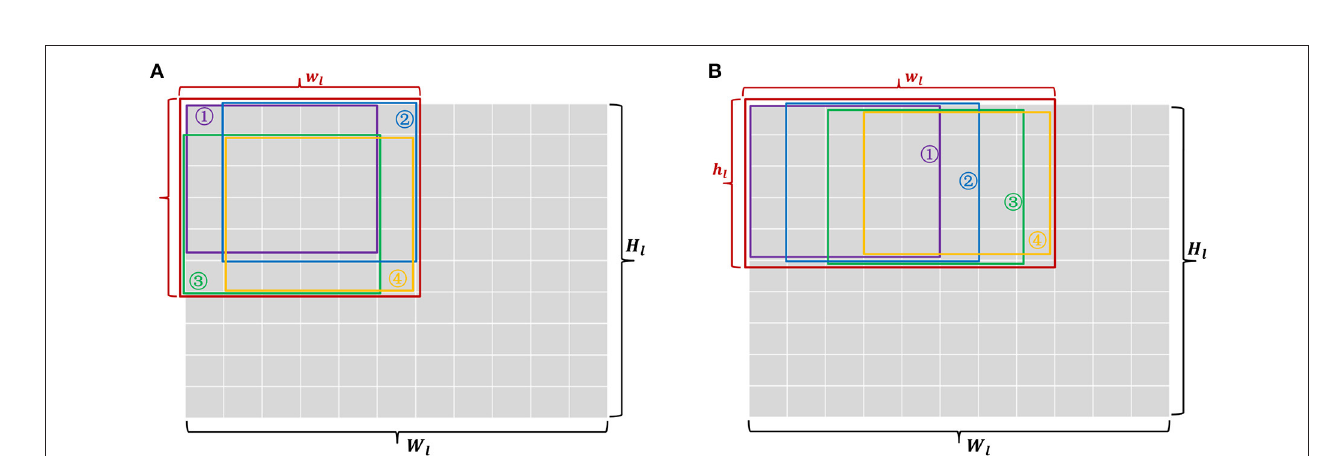
Frontiers in Neuroscience |